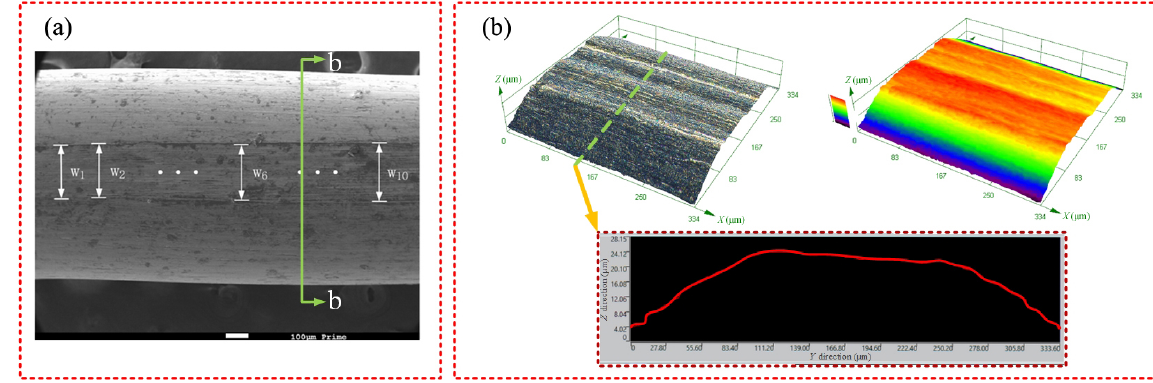
Fig. 7 Measurements of maximum wear depth and average wear width. (a) Width measurement, (b) depth measurement.